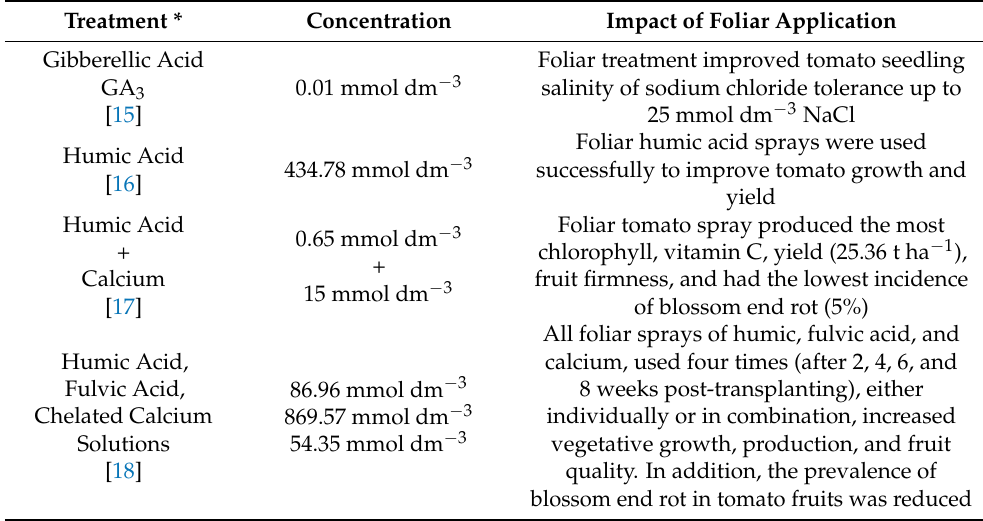
Table 2. Impact of foliar application trials of humic acid, fulvic acid, and gibberellic acid applied to tomato